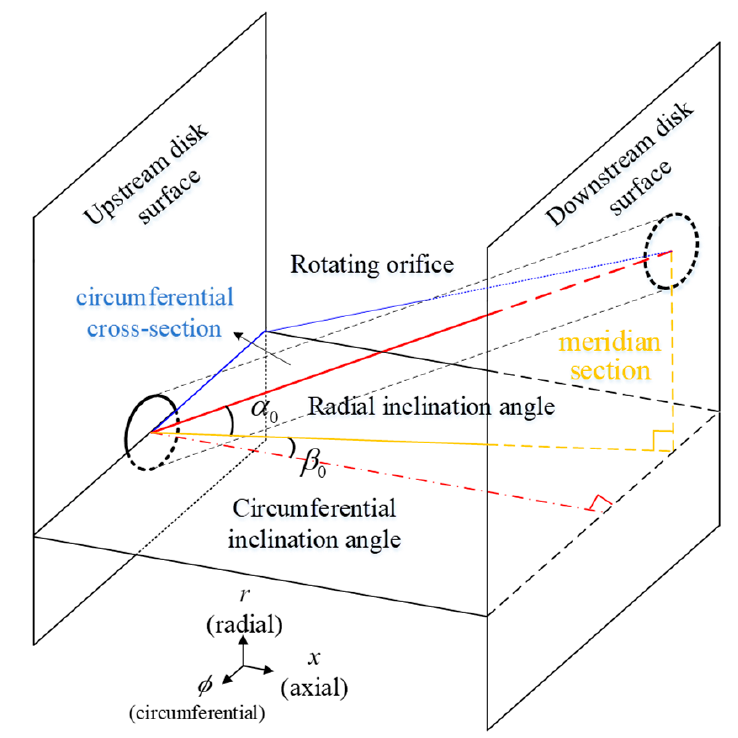
Figure 7. Schematic diagram of the Euler angle of the orifice. Table 2. Detailed parameter list of geometric model.